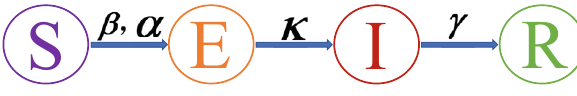
Fig. 1 State transition process of SEIR